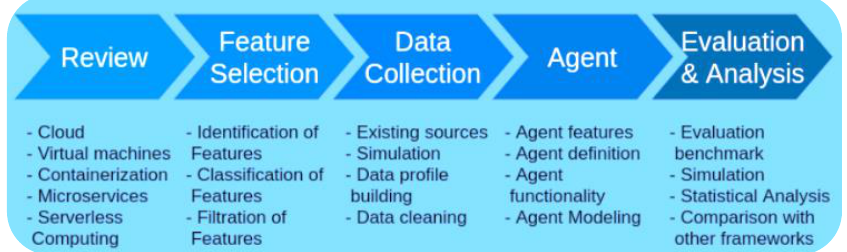
Figure 8. Layered representation of the proposed framework. 3.1. Intelligent Partitioning